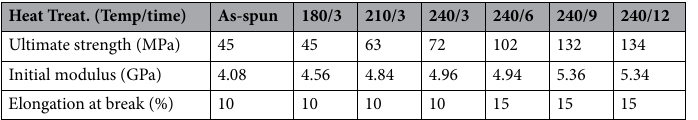
Table 5. The effects of heat treatment on the mechanical properties of Co-TLCP